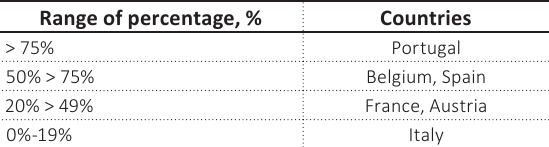
Table 2. The share of SMEs in all outstanding business loans in different EU countries, 2018, %